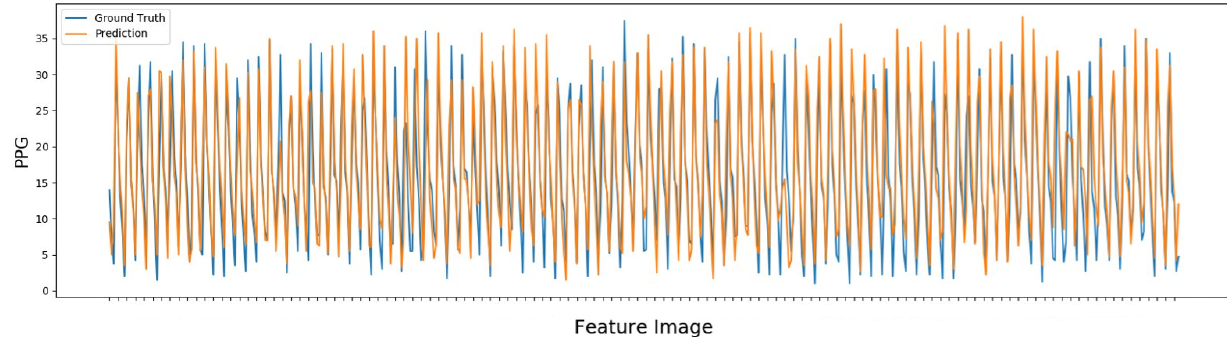
Figure 9. Prediction PPG of subject 49 of dataset UBFC.